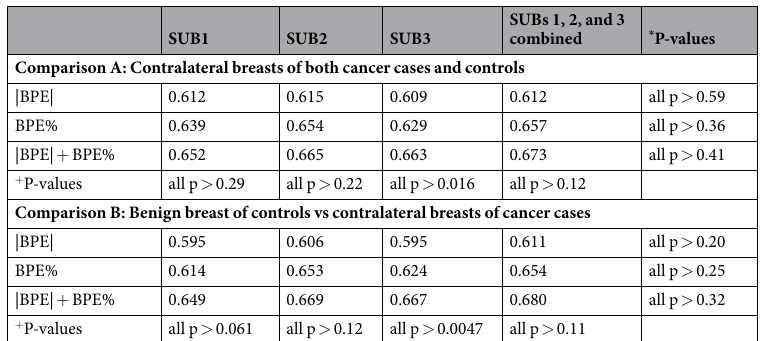
Table 4. AUCs of the unconditional logistic regression analyses for testing the BPE measures computed from three different SUBs on distinguishing cancer cases from controls. |BPE| = Volume of background parenchymal enhancement. BPE% = Percentage of background parenchymal enhancement volume (|BPE|) relative to breast volume. SUB1, SUB2, SUB3 = Subtraction sequence (i.e., post-contrast – pre-contrast) for each of first, second, and third post-contrast sequences, respectively. * P-values represent the DeLong’s test between any pair of the AUCs with respect to SUB1, SUB2, SUB3, and their combination (i.e., columns 2–5). + P-values represent the DeLong’s test between any pair of the AUCs with respect to |BPE|, BPE%, and their combination (i.e., rows 3–5 for Comparison A and rows 8–10 for Comparison